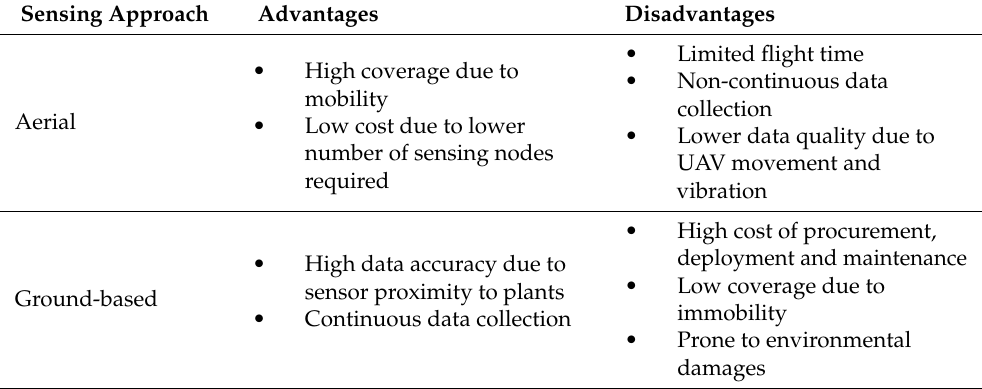
Table 1. Comparison of IoT-based precision agriculture sensing